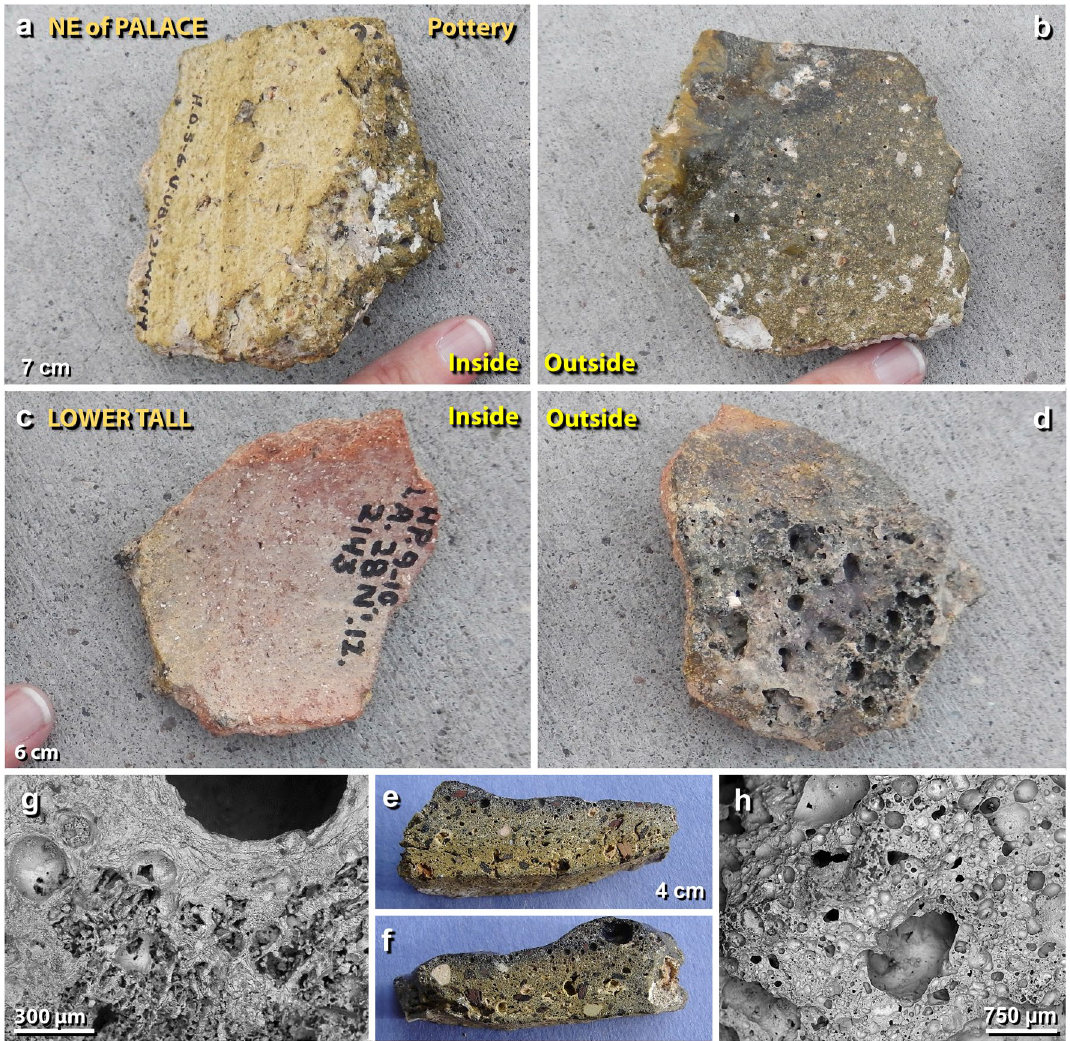
Figure 10. Melted pottery. ( a ) Photos of a 7-cm-wide potsherd from a broken storage jar from NE of the palace, showing unmelted inner surface and ( b ) the darker melted outer surface of the potsherd. The upper-left edge in panel ‘ b ’ is the outward-curved lip of a storage jar. ( c ) Potsherd of a 6-cm-wide storage jar from the lower tall, displaying an unaltered inner surface, and ( d ) the highly vesicular outer surface. ( e )–( f ) Photos of both edges of the sliced section of sherd in panels ‘ a ’ and ‘ b ’ above. ( g )–( h ) SEM images of the highly vesicular sliced surface of sherd in panels ‘ a ’ and ‘ b